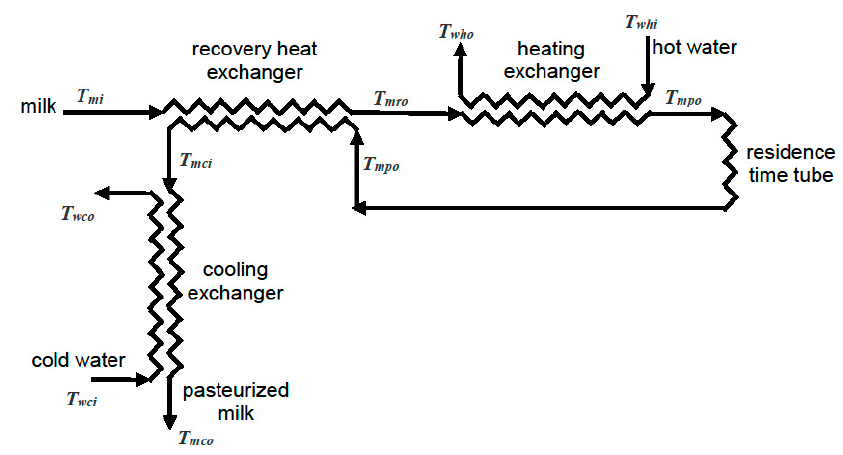
Figure 1. Flow chart of thermal exchangers system of the milk pasteurization.